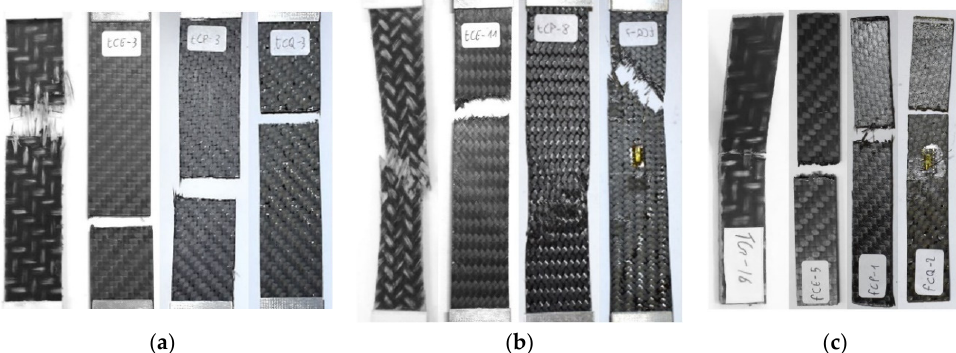
Figure 19. Comparison of di ff erent breaking behavior of the four materials (from left to right for each